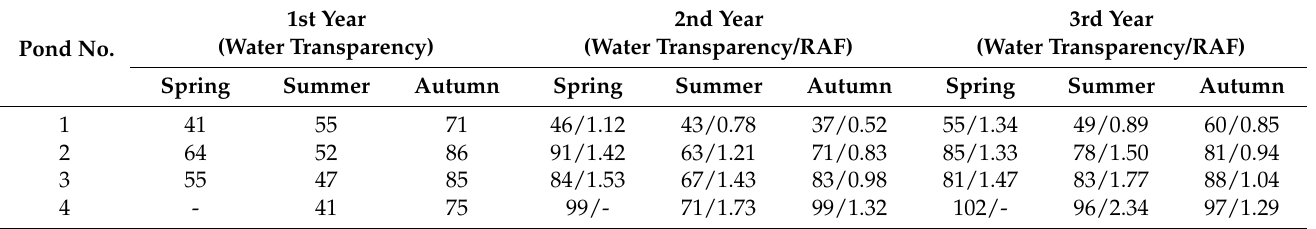
Table 5. Quarterly statistics of the average value of water transparency (cm) and RAF 1 at each